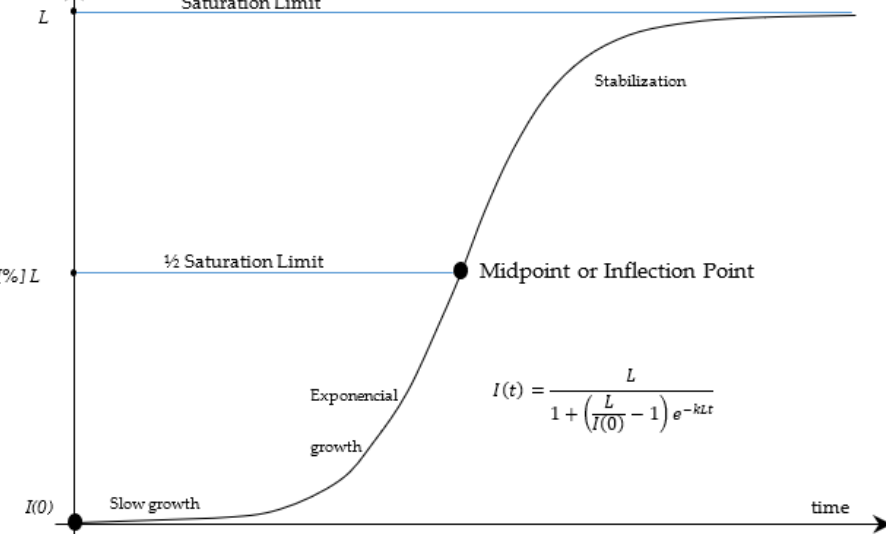
Figure 3. General shape of the logistic growth S-shaped curve.